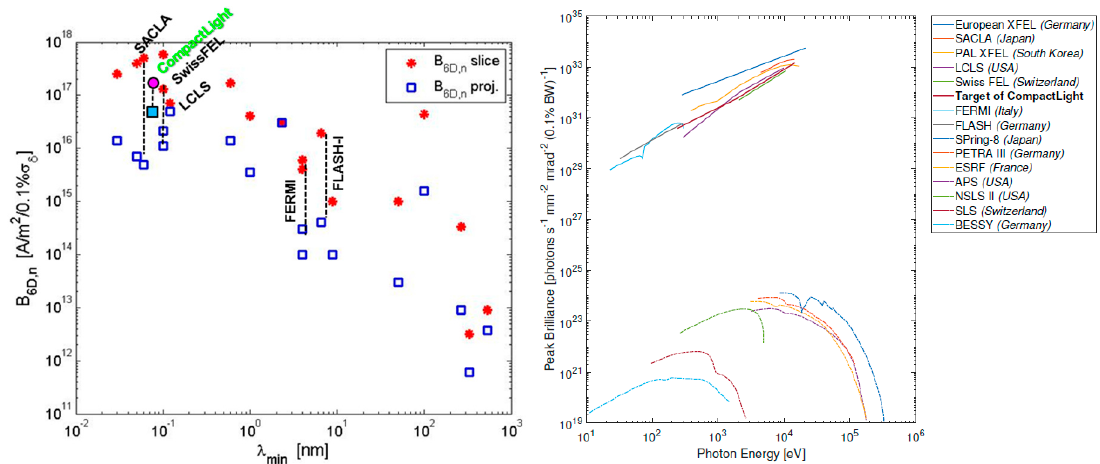
Figure 1. 6-dimensional normalized electron beam brightness from projected and core-slice parameters (left, adapted from [3]), and peak photon brilliance (right) for existing and planned short-wavelength FELs. The CompactLight electron beam brightness (filled markers) and brilliance are reported for the nominal bunch charge of 75 pC.